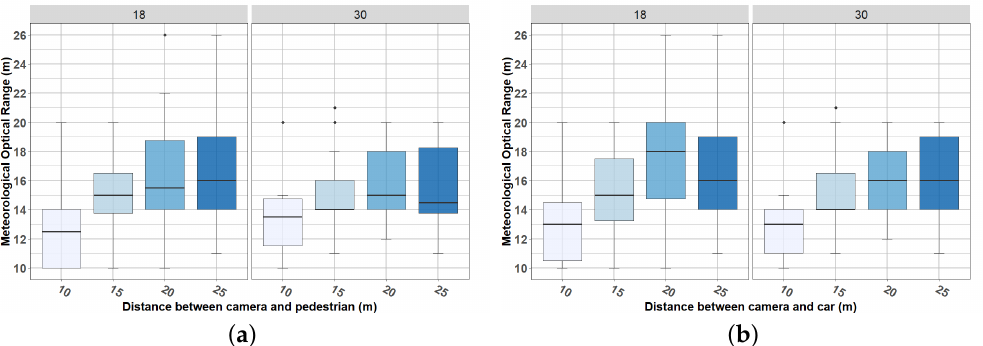
Figure 22. Meteorological optical range at which the car and the pedestrian started to be distin- guished by human observers. ( a ) Visual validation—Pedestrian detection; ( b ) Visual validation— Car